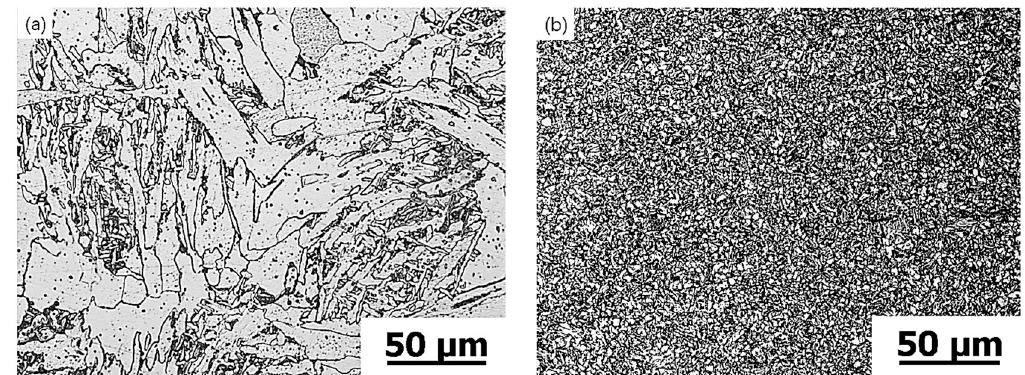
Figure 11. Optical micrographs of the HAZ with different alloy addition sequences: ( a ) Al–Ti–Mg; and ( b ) Al–Mg–Ti.